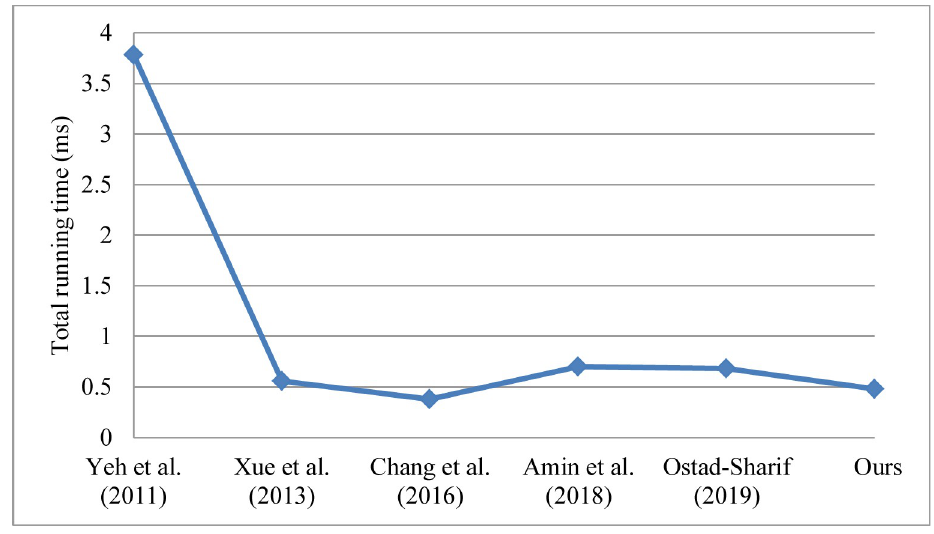
Fig 6. Comparison of running